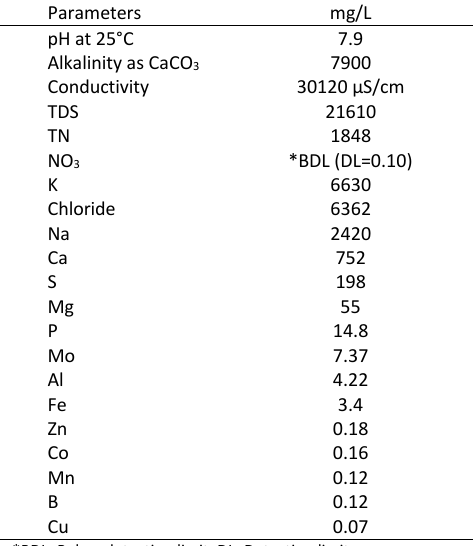
Table 1: Physicochemical characterization of cattle